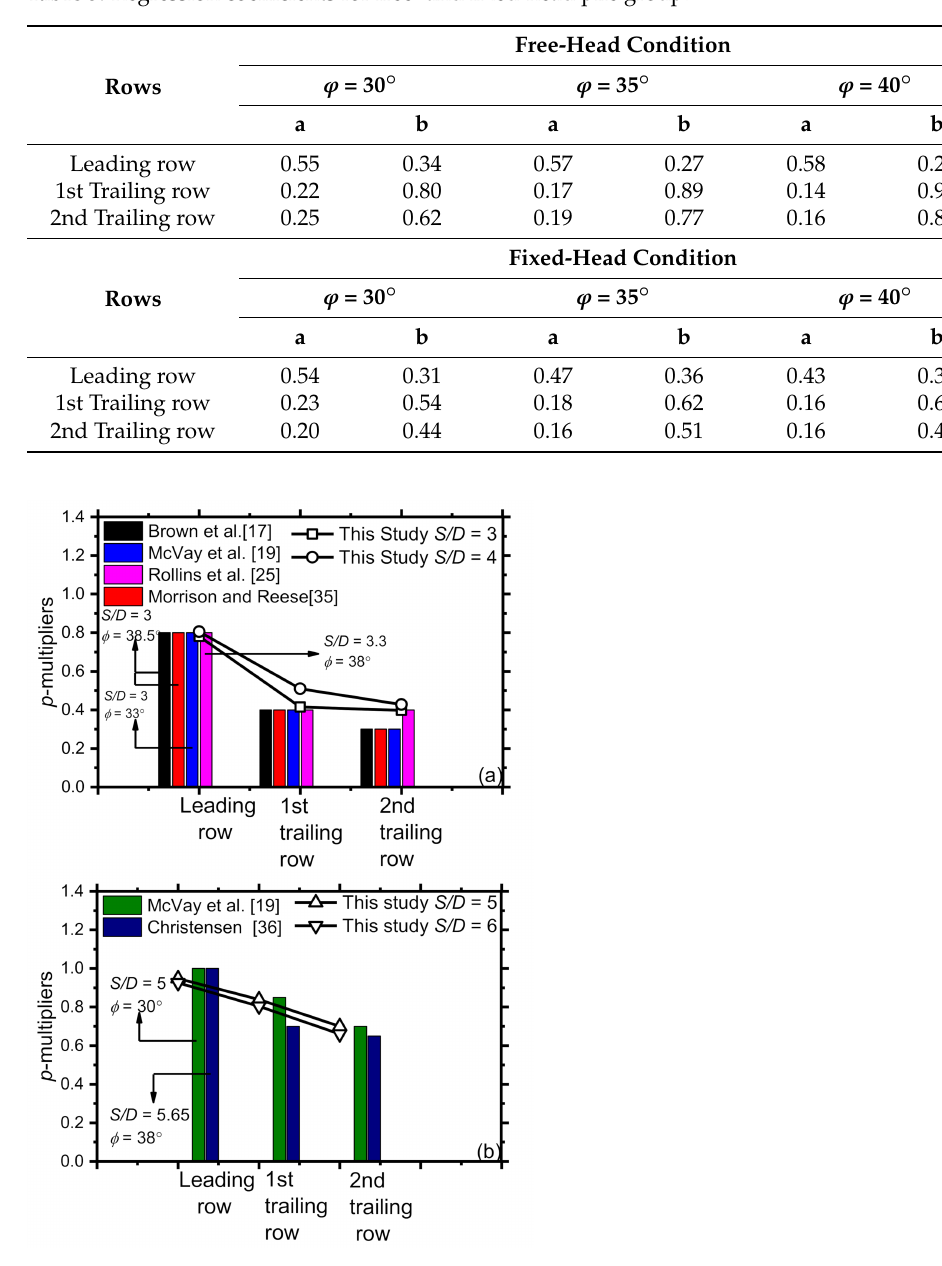
Figure 7. Comparison between calculated p -multipliers and previous experimental work for free- head pile groups in sand with 3 × 3 pile configuration: ( a ) S/D = 3, 3.3 and ( b ) S/D = 5,